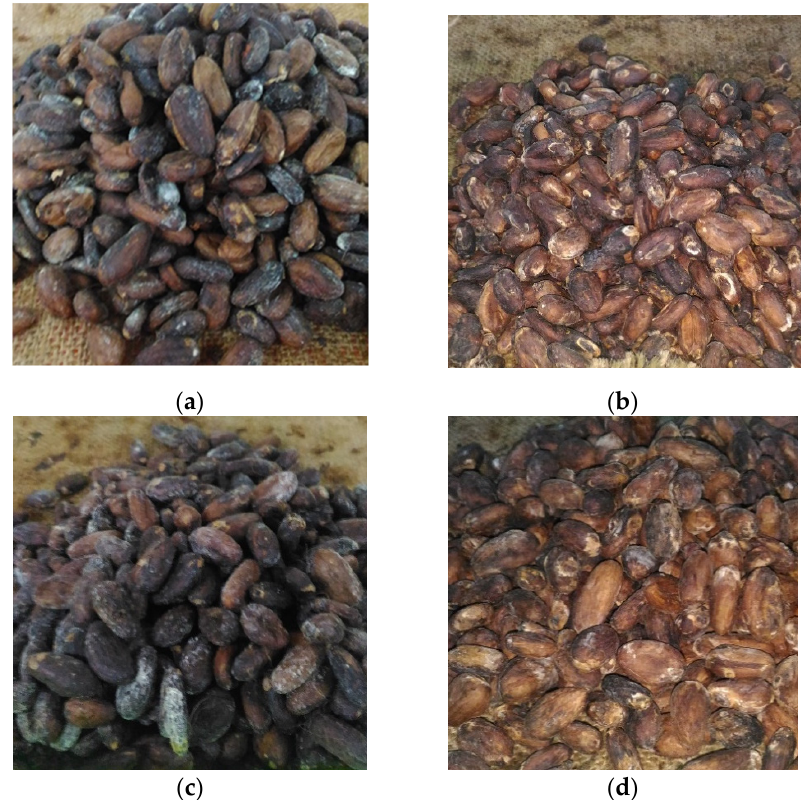
Figure 7. The appearance of fungal mycelia on the surfaces of the dry cocoa beans (days 10): ( a ) natural fermentation; (b) fermentation of cocoa beans with the addition of L. plantarum HL-15 and A. niger YAC-9; ( c ) cocoa bean fermentation with the addition of A. niger YAC-9; (d) cocoa bean fermentation with the addition of a mixed starter consisting of L. plantarum HL-15, C. famata HY-37, Acetobacter spp. HA-37, and A. niger YAC-9. There were no fungal mycelia in the treatments in ( b , d ). The color of the fermented cocoa beans that were contaminated by A. niger was blackish brown, as shown in ( a , c